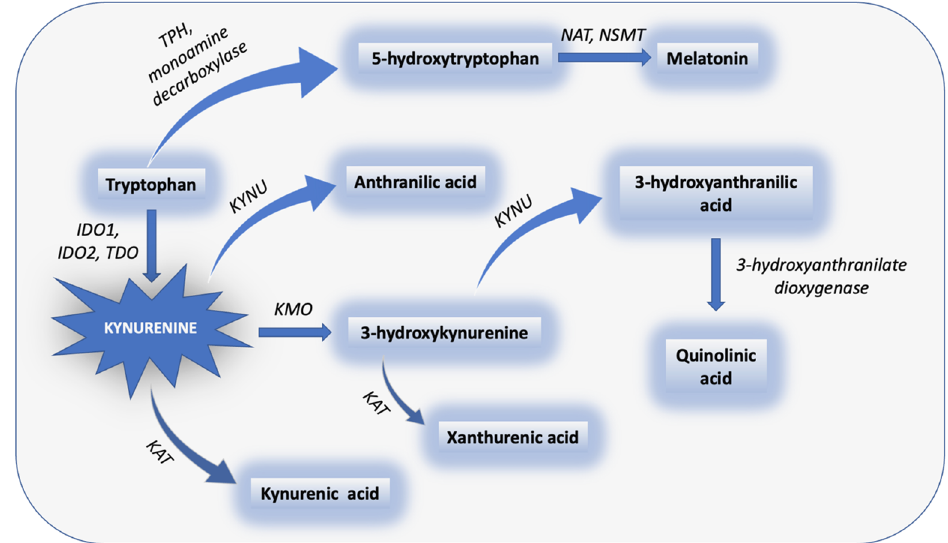
Figure 1. The kynurenine and serotonin pathway. Abbreviations: IDO1, indoleamine 2,3-dioxygenase 1; IDO2, indoleamine 2,3-dioxygenase 2; TDO, tryptophan 2,3-dioxygenase; KAT, kynurenine aminotransferase; KMO, kynurenine 3-monooxygenase; KYNU, kynureninase; TPH, tryptophan hydroxylase; NAT, N-acetyltransferase; NSMT, N-acetylserotonin O-methyltransferase. On the endocrine front, TRP partakes in the synthesis of serotonin and melatonin. [24] TRP is converted into serotonin by the processes of hydroxylation (via tryptophan hydroxylase [TPH]) and decarboxylation (via monoamine decarboxylase (5-hydroxytryp-